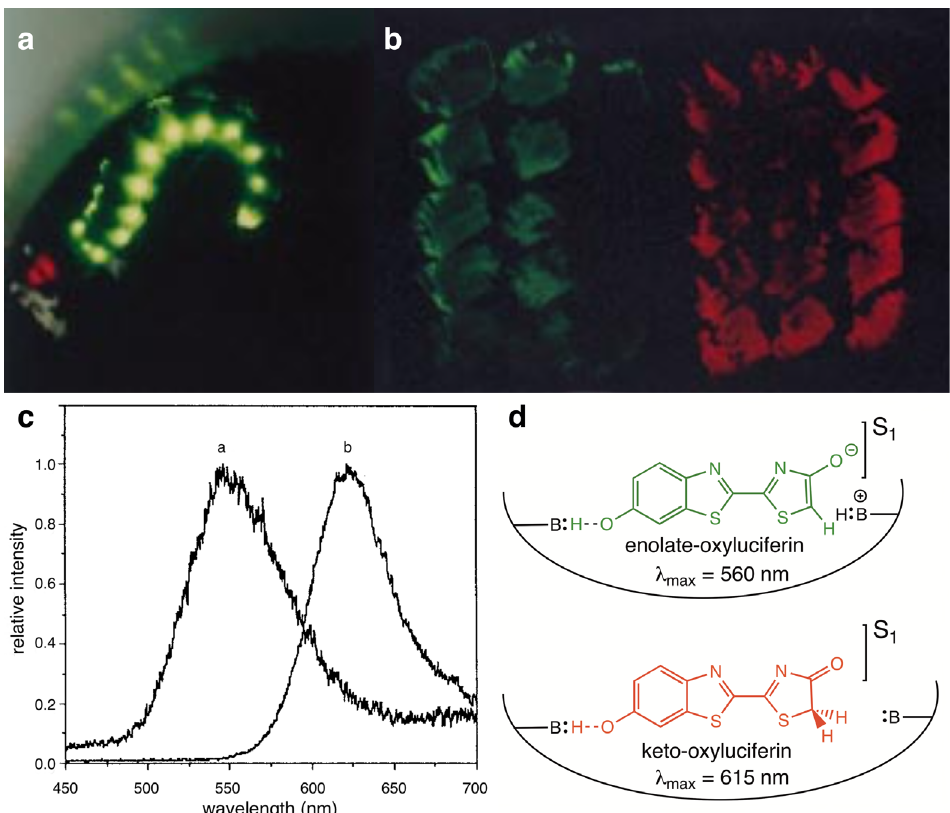
Figure 6 - Color modulation by the abdominal yellow-green and cephalic red lanterns of Phrixothrix heydeni (Phengodidae) ( a ). Panel b displays luciferase-expressing E. coli colonies and Panel c , the corresponding emission spectra peaking at the yellow-green (560 nm) and red (615 nm) regions. Panel d outlines the mechanism of basic amino acid effect on the partition of excited oxyluciferin into enolate (yellow-green) and keto (red) forms at the luciferase active site. Modified from Viviani et al. (1999). Copyright 1999 American Chemical